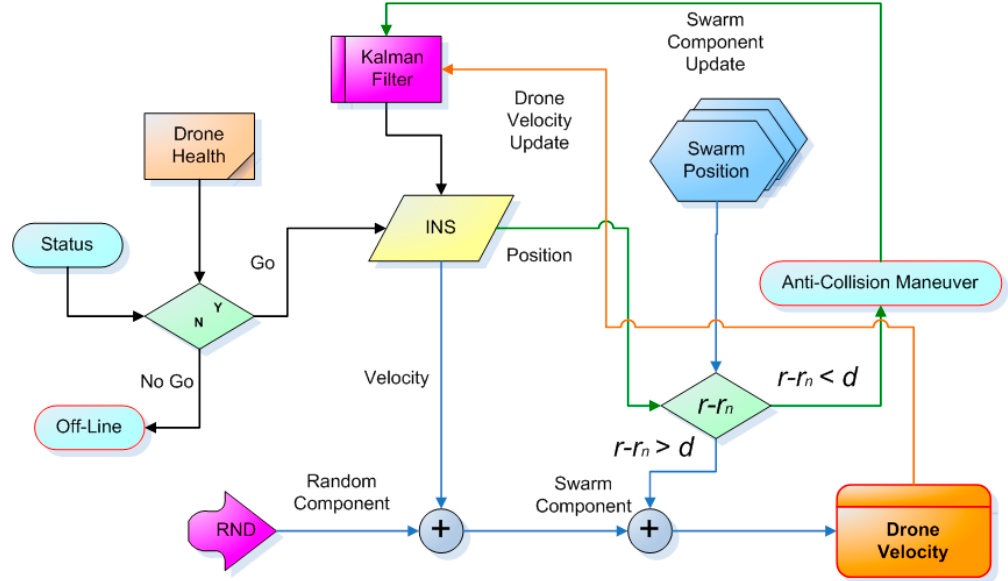
Figure 7. Block diagram of the essential functions of a single drone and the interaction with the environment.